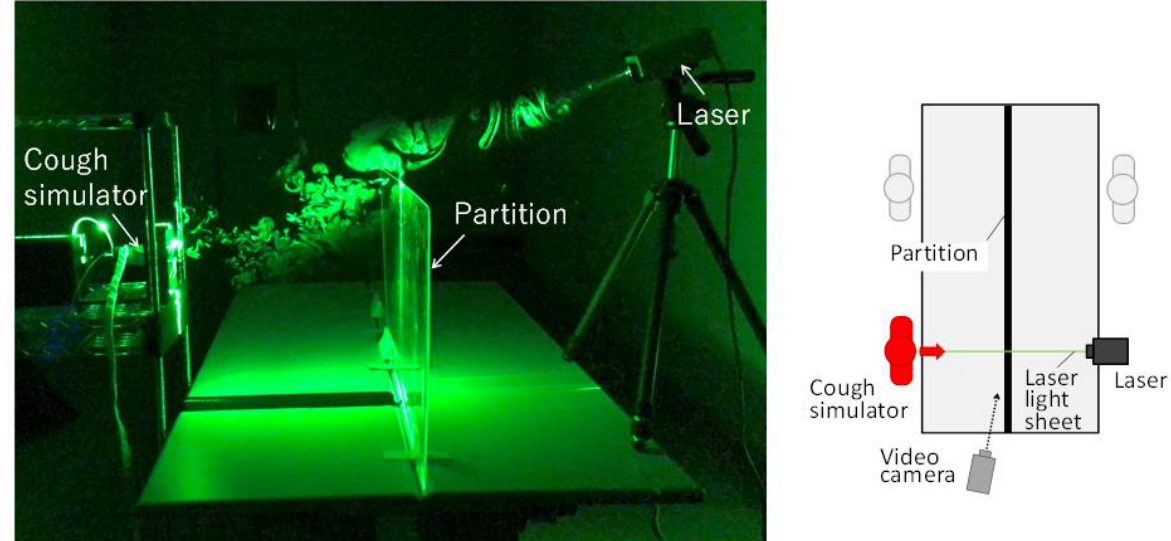
Figure 5. Aerosol overcoming partitions.